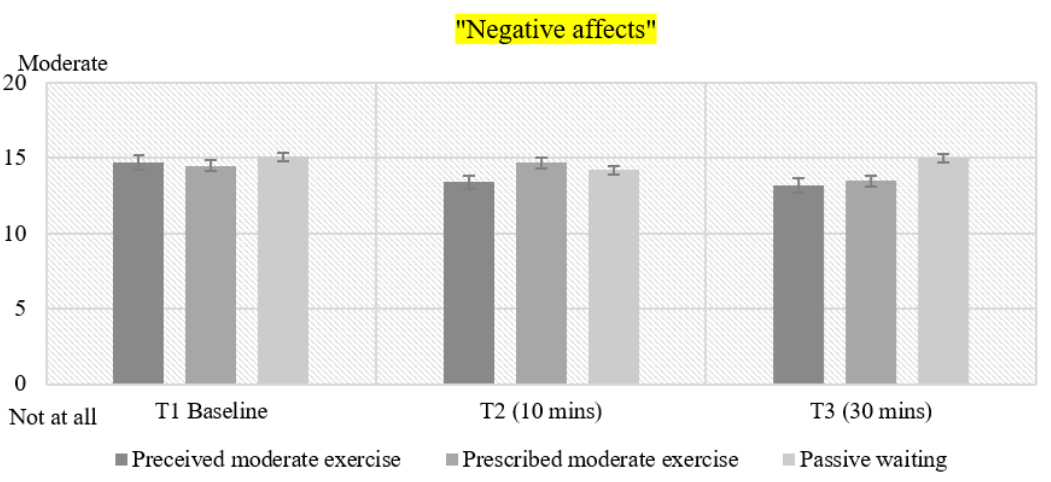
Figure 4. Mean values for Negative affect (PANAS) in all conditions. T1: Time 1—Baseline pre- intervention. T2: Time 2–10 min of exercise. T3: Time 3–30 min post-intervention.